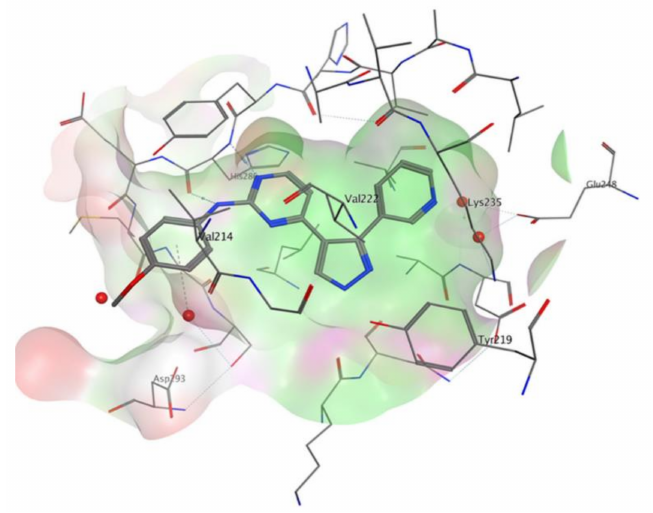
Figure 82. In silico binding interactions of RK-59638 ( 75 ) with ALK2 (R206H) crystal structure